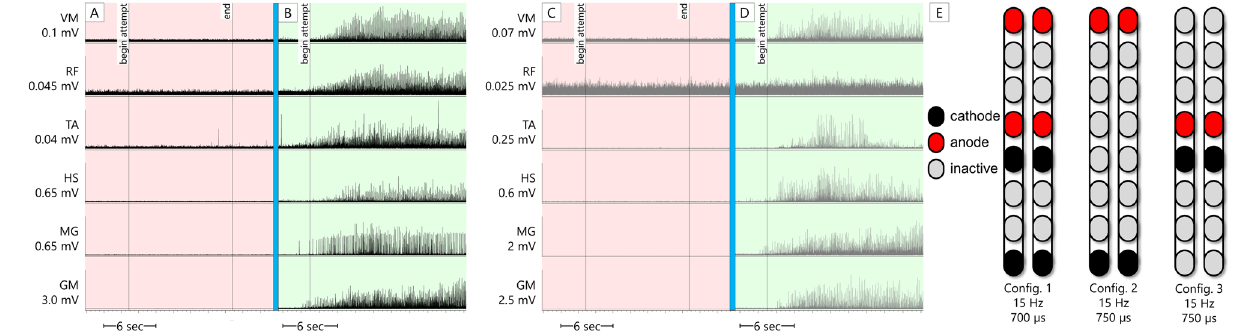
Fig. 5 | 0772 Exoskeleton sit-to-stands. Electromyograms (EMGs) of lower extre- mity muscles of 0772 during active attempts to complete a sit-to-stand maneuver with the exoskeleton in “ Squat ” mode. In this mode, the exoskeleton will not pas- sivelycompleteasit-to-standfortheuser;rather,assistivetorqueisprovidedatthe kneesandhipswhichcanenabletheusertocompleteasit-to-standonlyiftheyare able to volitionally contribute to the movement. The assistance level was set to “ very high ” , which is the highest of four levels of manufacturer-determined assis- tance. A , C left (black traces) and right (gray traces) leg muscles, respectively, during anactive attemptto complete a sit-to-stand with SCESoff. 0772was unable